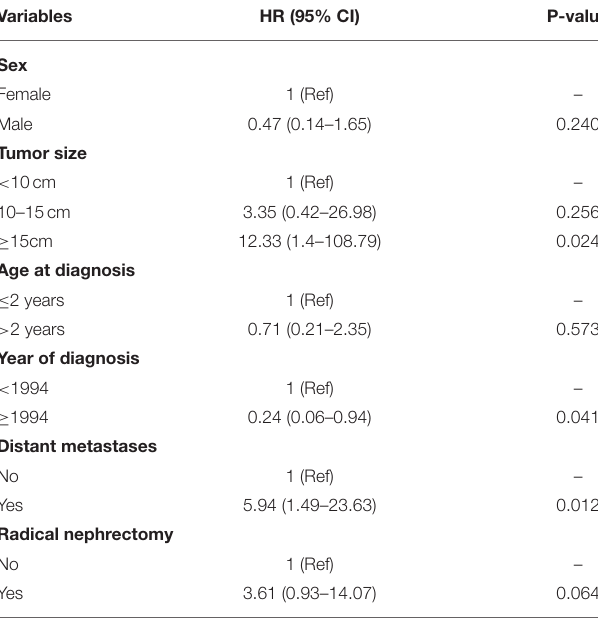
TABLE 1 | The clinical features and 5-year OS rates of CCSK cases aged 0 to 19 years during 1975–2016 in the US.